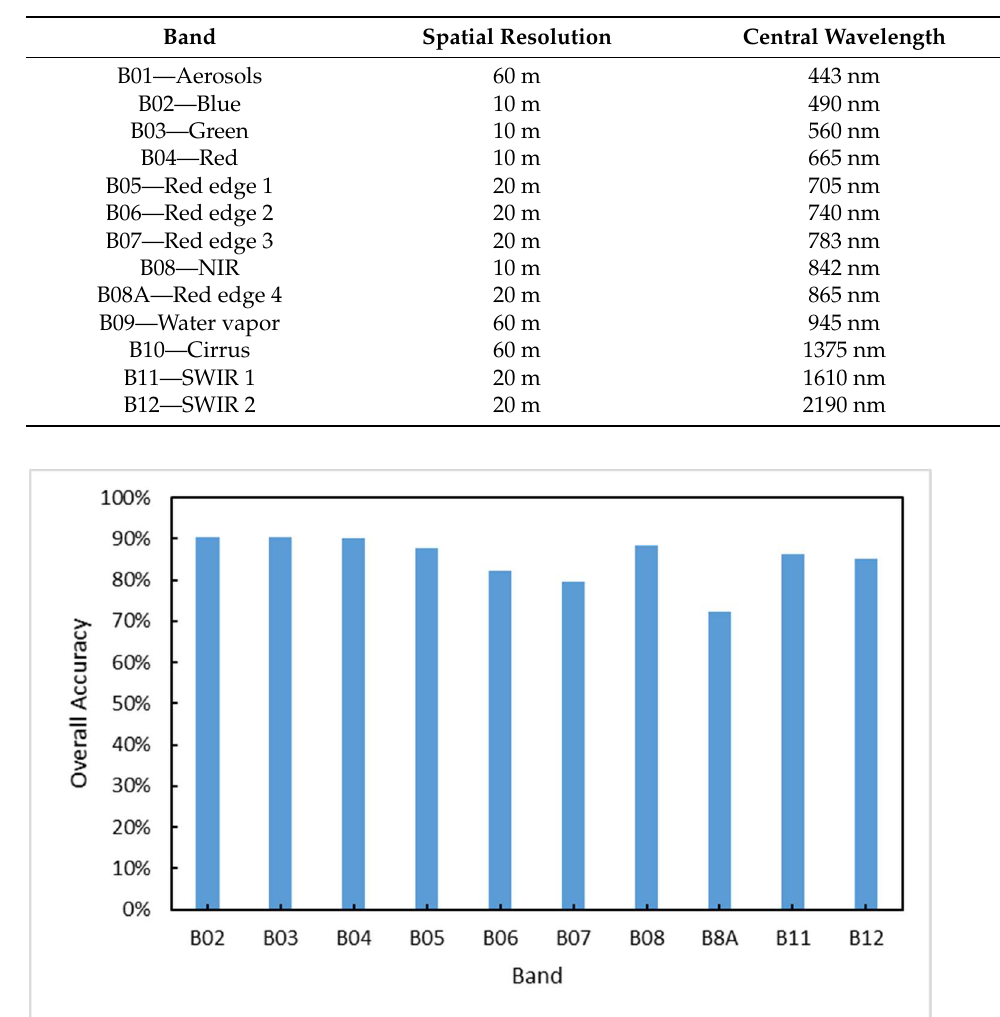
Figure 13. Overall classification accuracy using single-band images. Table 8. OA of different band combinations.